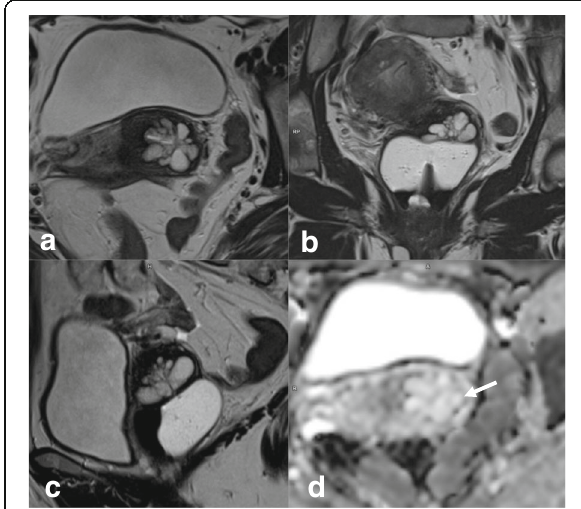
Fig. 21 Adenoma malignum visualized by axial oblique T2WI ( a ), coronal T2WI ( b ), sagittal T2WI ( c ), and DCE ( d ). Multicystic lesions extend from the endocervical glands to the deep cervical stroma with solid components, forming a mass